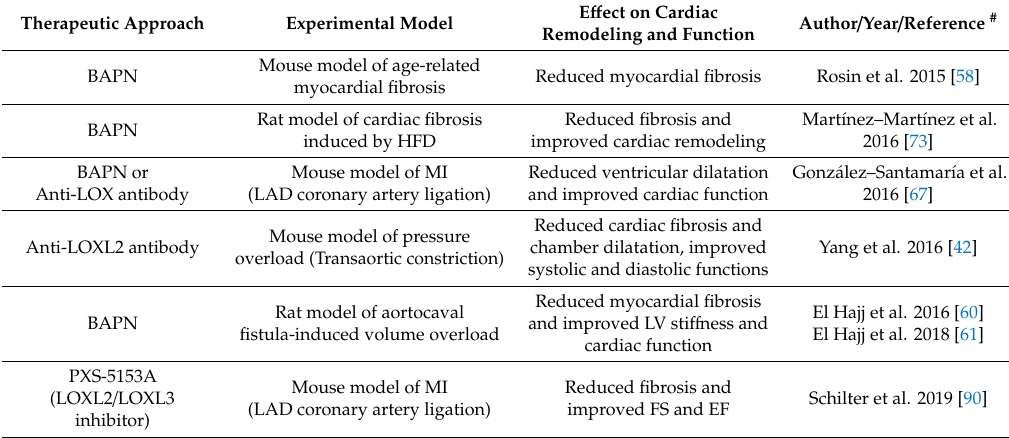
Table 1. Therapeutic approaches targeting LOX and